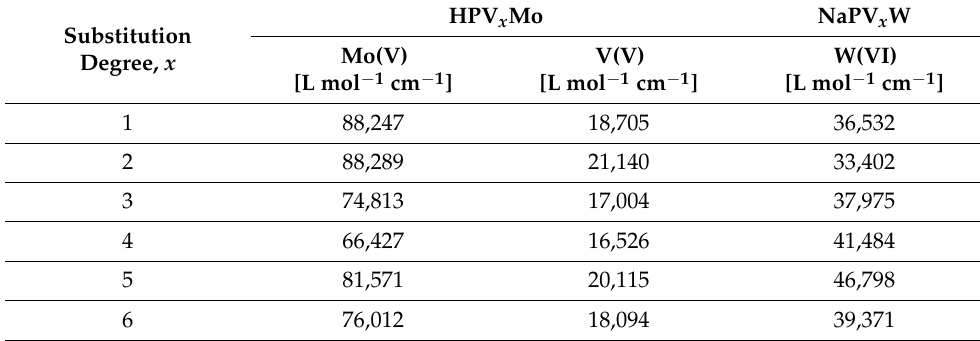
Table 6. Extinction coefficients, ε λ , calculated for the different LMCT